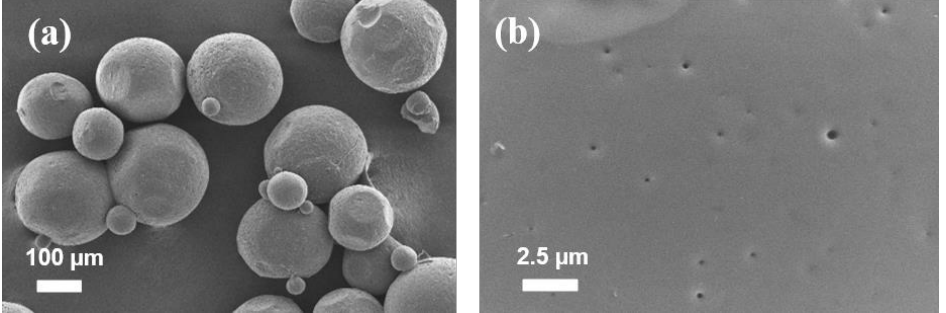
Figure 5. SEM images of microparticles and surface morphology of optimized microparticles; ( a ) particles and ( b ) surface morphology. Scale bars are shown on individual photographs.